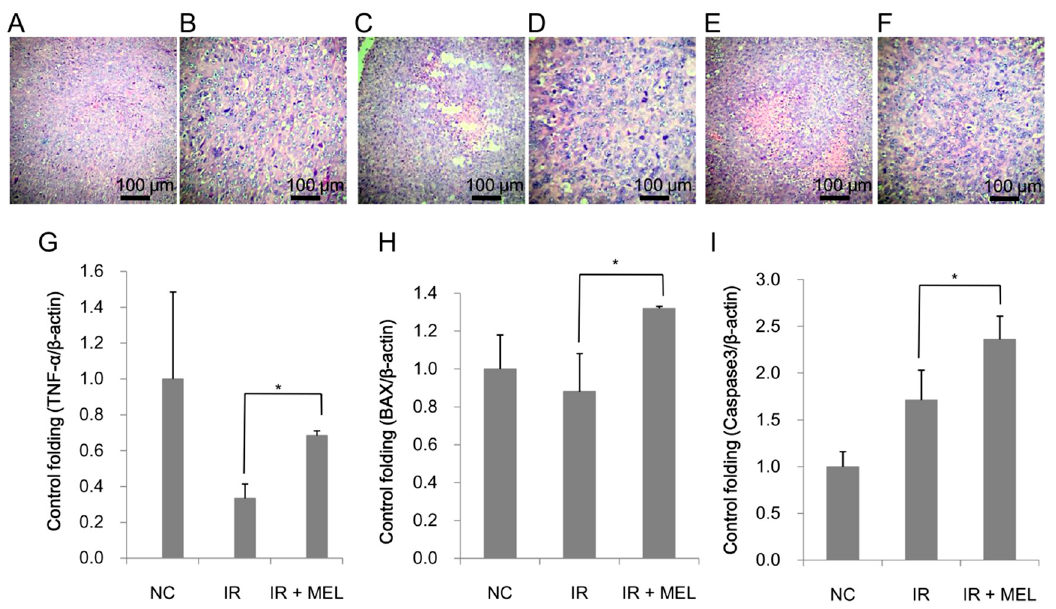
Figure 8. Histological organization of tumor tissues of mice in NC ( A , B ), IR ( C , D ) and IR + MEL ( E , F ) treatment groups. The relative expression levels of TNF- α ( G ), Bax ( H ), and Caspase 3 ( I ) in tumor tissues of mice in NC, IR, and IR + MEL treatment groups. β -actin was used as an internal control. NC, mice receiving no treatment; IR, mice treated with a single dose of X-ray radiation; IR + MEL, mice treated with 40 mg / kg nanomelanin once before X-ray radiation and again 2 days post-radiation. *: Significant difference with P < 0.05 from the control by the Student’s t-test. It was clear that the tumor consisted of epithelial lung cancer cells with irregular, hyperpigmented and multiple